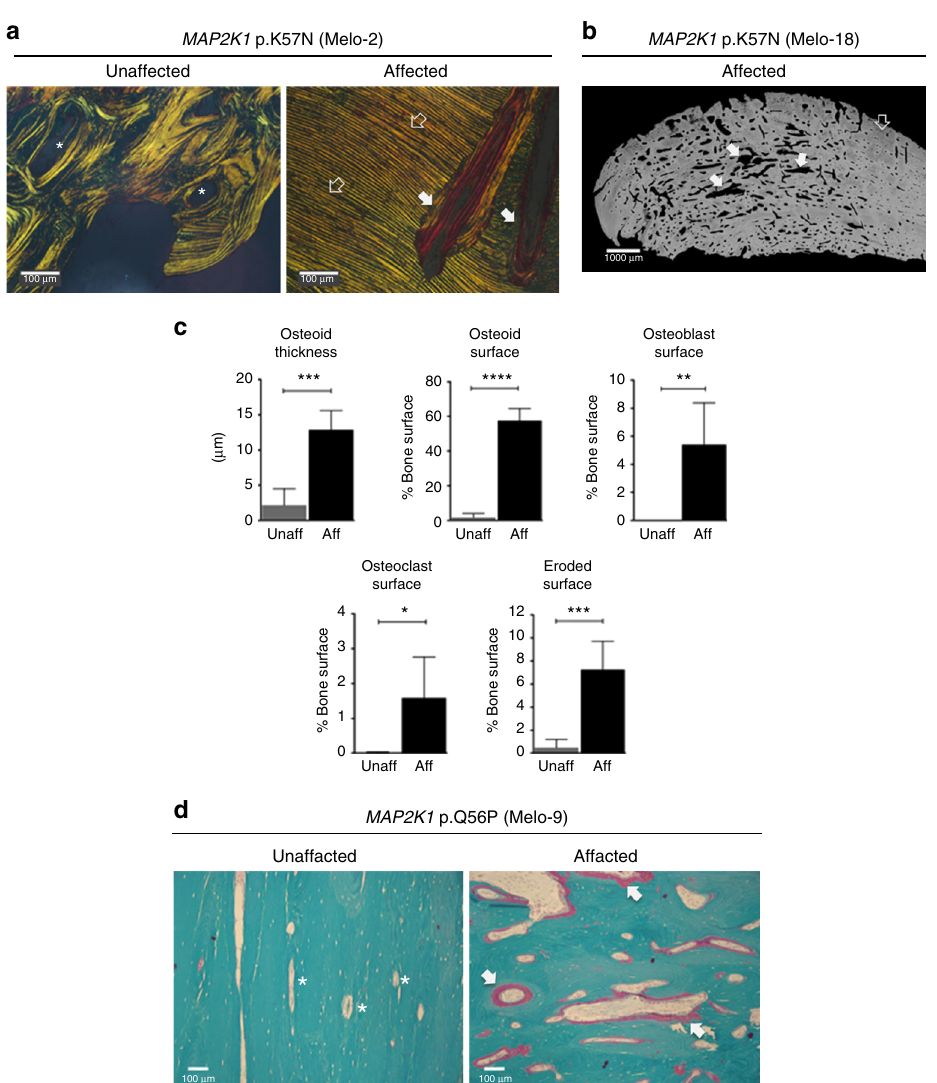
Fig. 3 Intense bone remodeling and abnormal mineralization in melorheostosis. a Light microscopy images of cortical bone from patient Melo-2 showing the orientation of the collagenous matrix. Goldner ’ s trichrome staining is viewed under polarized light. Affected bone tissue shows in the periosteal regions appositional growth through deposition of layers of compact primary lamellar bone oriented parallel to the periosteal surface (open arrows). Subsequently these regions become highly remodeled. The solid arrows point towards large canals traversing the parallel layers of primary bone. Note the thick osteoid seams (red, unmineralized matrix) in affected bone tissue, whereas no osteoid is seen in unaffected bone (asterisks). b A backscattered electron image (BEI) of affected bone tissue from patient Melo-18. Gray represents the mineralized bone tissue, black is non-mineralized tissue. Note the extreme porosity of the bone tissue as a consequence of an intense bone remodeling activity (solid arrows). The open arrow is the same area labeled by the open arrow in a . c Bone histomorphometry. Comparison of indices of bone formation and bone resorption of affected vs. unaffected bone tissue from six patients with MAP2K1 mutations. All indices of bone formation and bone resorption are signi fi cantly increased in affected bone tissue compared to unaffected bone of the same patient. * p < 0.05; ** p < 0.01; *** p < 0.001; **** p < 0.0001 vs. values of unaffected bone tissue (paired t -test). Unaff: unaffected bone tissue, Aff: affected bone tissue. d Overviews of unaffected and affected bone tissue obtained from patient Melo-9. Affected bone can be easily recognized by its porosity and by the substantial portions of unmineralized matrix (solid arrows), while osteoid formation is not seen around osteonal canals in the unaffected bone sample (asterisks). Goldner ’ s trichrome staining followed by light microscopy in the bright- fi eld mode. Green indicates mineralized bone matrix and red indicates unmineralized